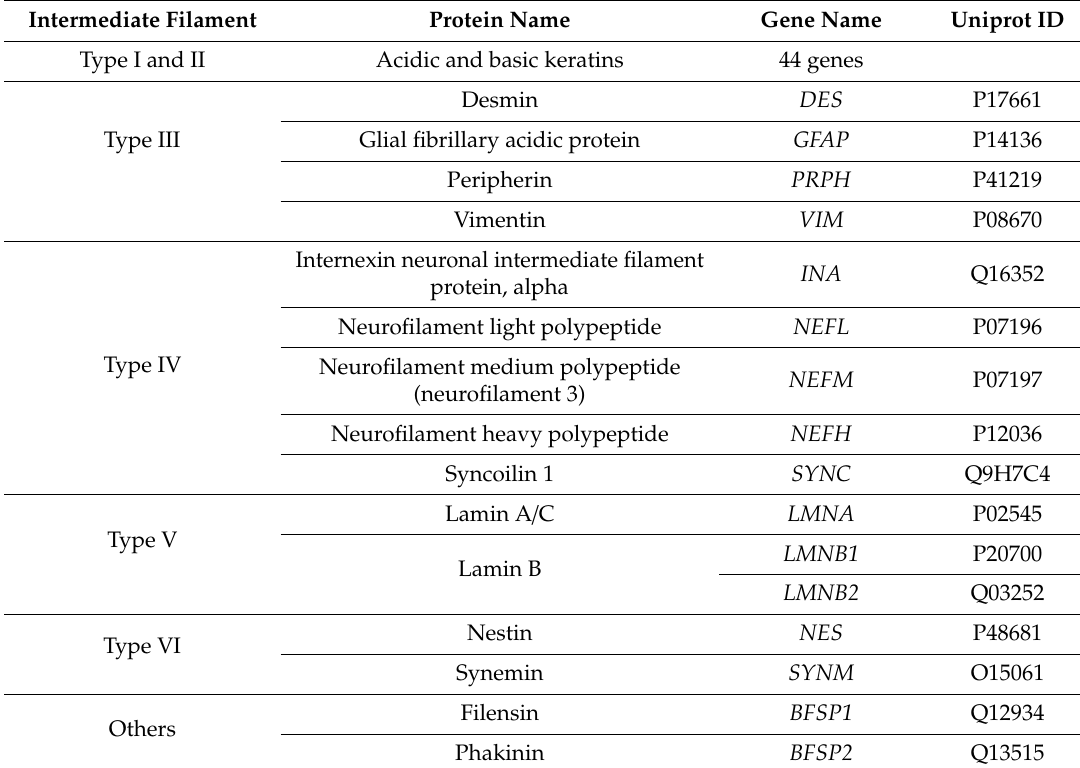
Table 1. Classification of intermediate